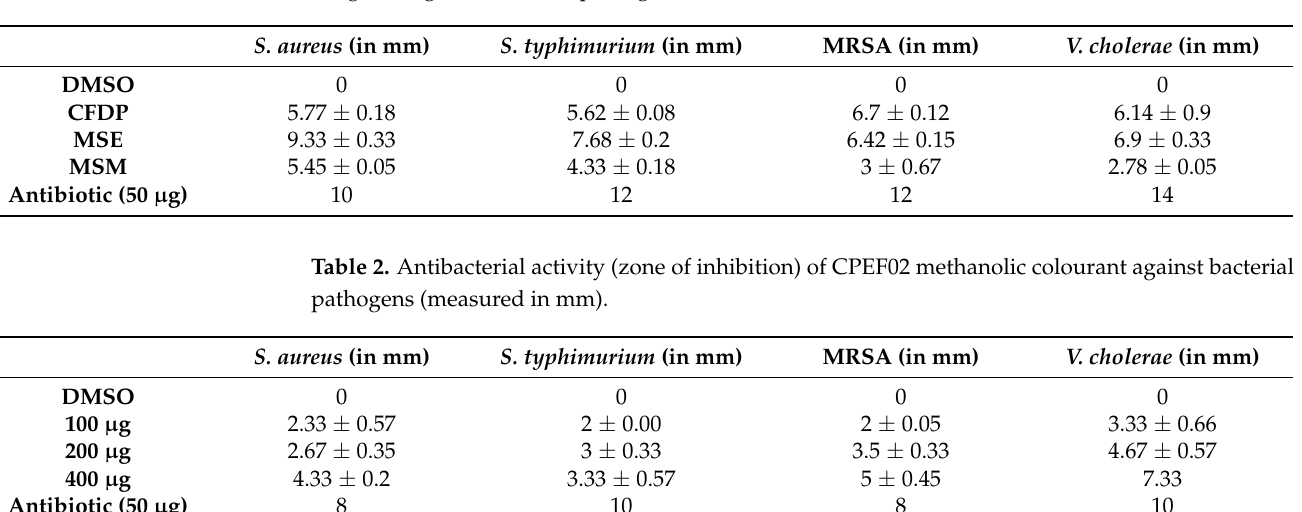
Figure 3. ( A ) Disc diffusion assay of CPEF02 (inhibition zone measured in mm); ( B ) antibacterial activity of CPEF02 extracts (CFDP, MSE and MSM) at the concentration of 1 mg/mL; ( C ) antibacterial activity of CPEF02 methanolic extract (MSM) at different concentrations against bacterial pathogens S. aureus (AM01), S. typhimurium (AM02), methicillin-resistant S. aureus (AM03) and V. cholerae (AM04). Table 1. Antibacterial activity of CPEF02 extracts CFDP, MSE and MSM at the concentration of 1 mg/mL against bacterial pathogens (measured in mm).